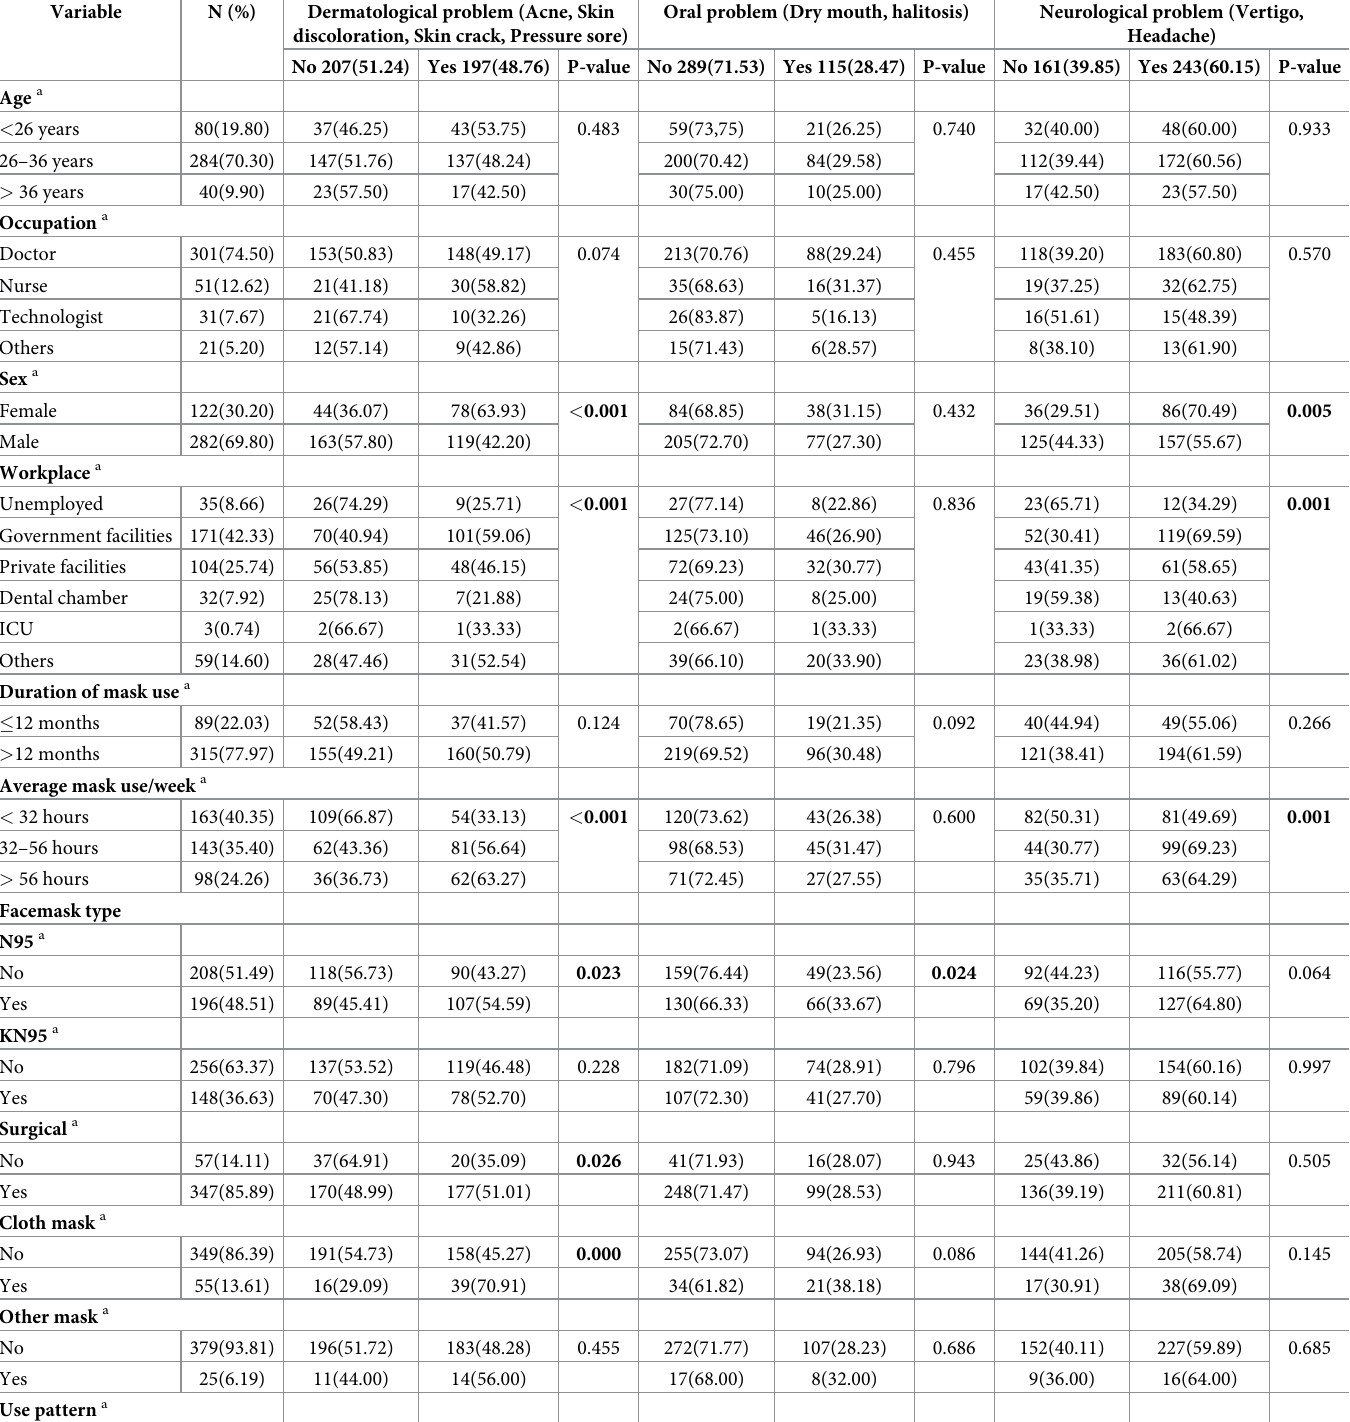
Table 2. Prevalence of dermatological, oral and neurological problems from face mask use.